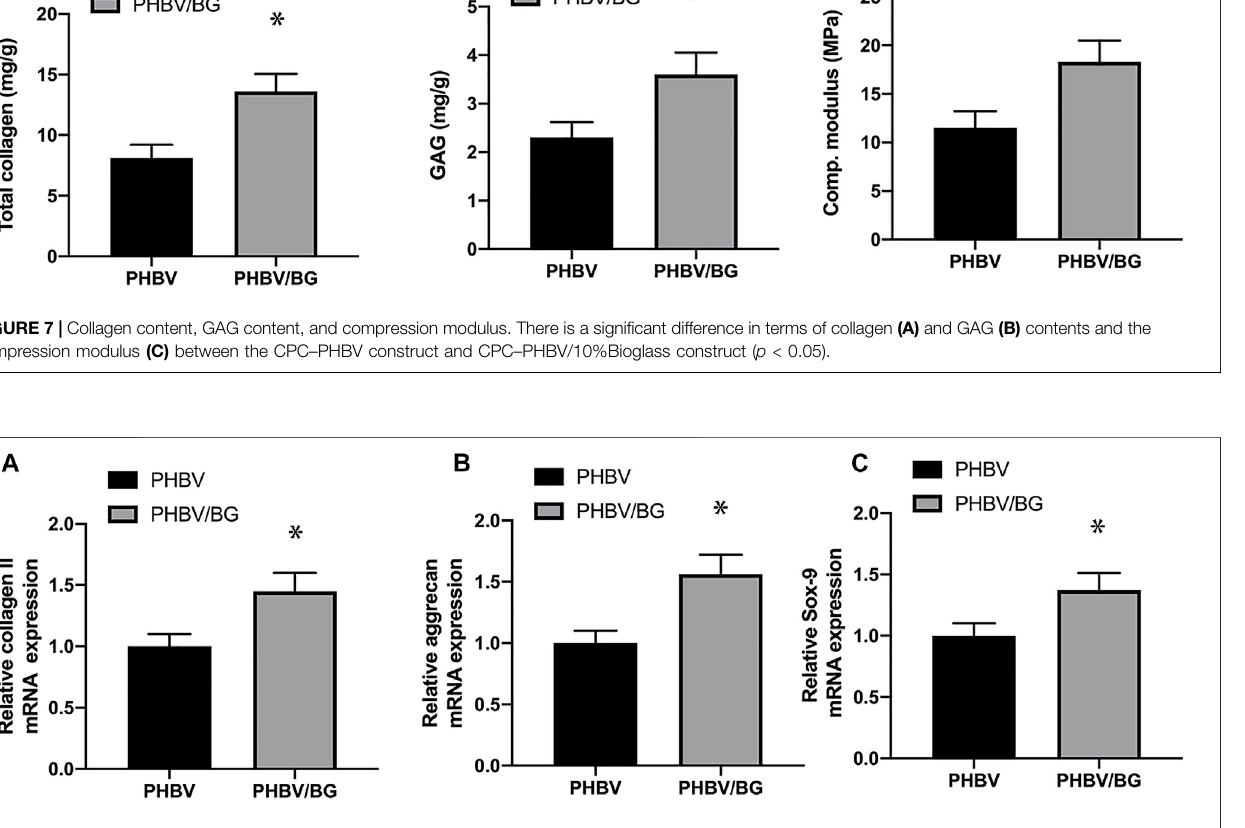
FIGURE 8 | Chondrogenic differentiation of the CPC – PHBV construct and CPC – PHBV/10%Bioglass construct. RT-PCR analysis reveals the stronger expression of COL II (A) , aggrecan (B) , and the SOX-9 gene of the CPC – PHBV/10%Bioglass construct than the CPC – PHBV construct ( p <